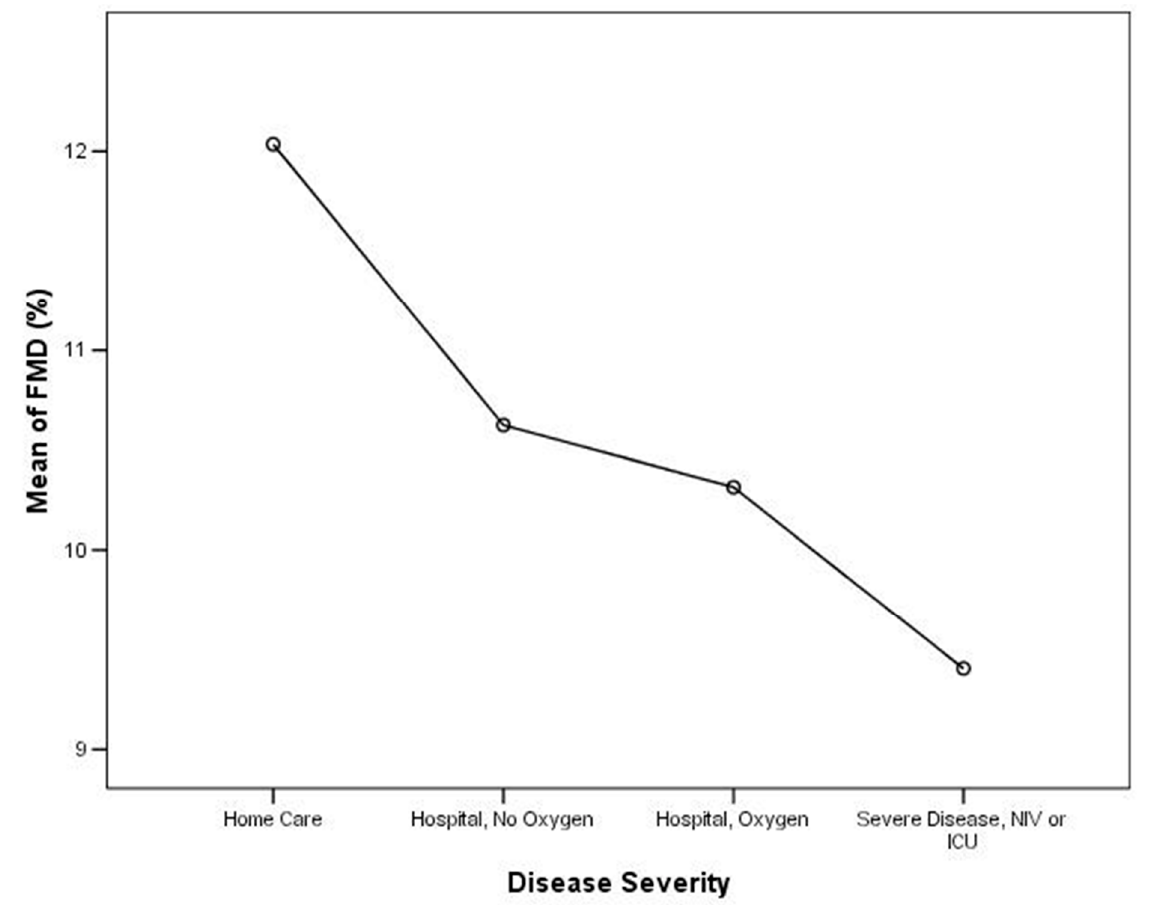
Figure 1. Analysis of variance for FMD and disease severity ( p < 0.0001 for trend).